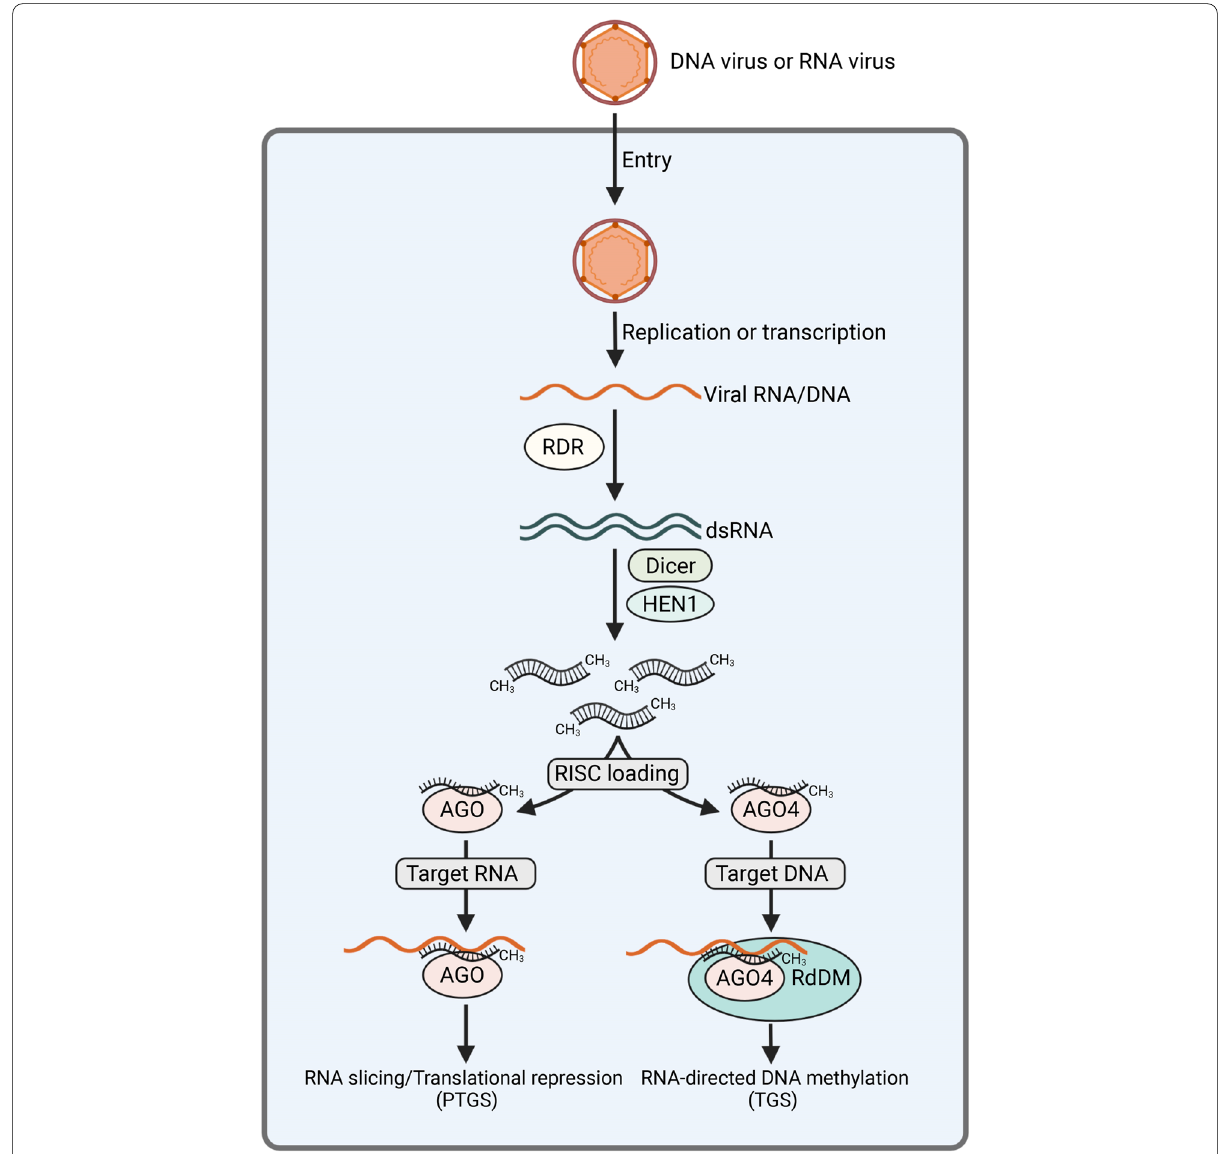
Fig. 1 Schematic diagram depicting plant RNAi pathway activated by virus infection. Replication of RNA viruses produce dsRNA intermediates, and they serve as inducers of post-transcriptional gene silencing (PTGS). Infection by DNA viruses also induces RNA-directed DNA methylation (RdDM), which is involved in modification of DNA and/or histones, result in transcriptional gene silencing